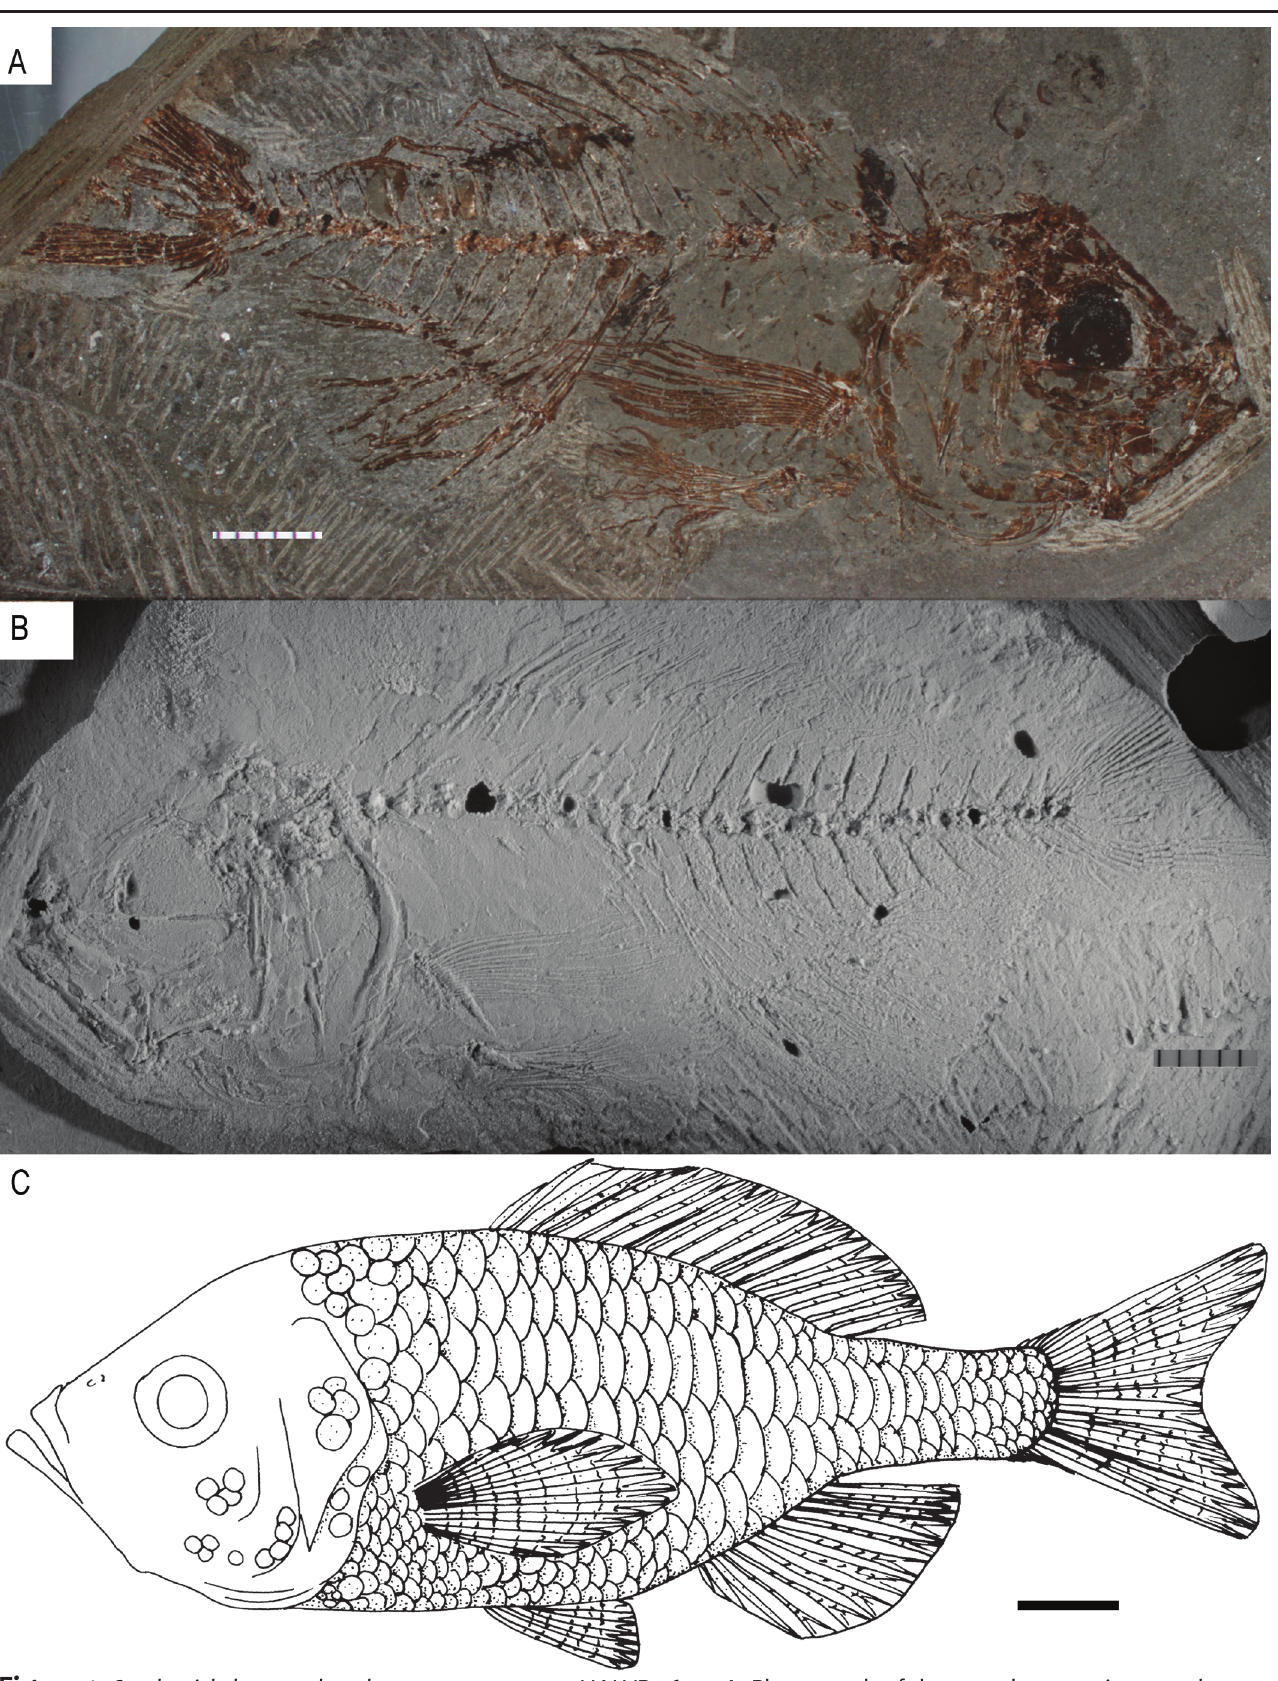
Figure 1. Cumbaaichthys oxyrhynchus gen. et sp. nov., UALVP 56113. A, Photograph of the complete specimen under polarized light; B, a silicone peel of the specimen coated with ammonium chloride; C, reconstruction of the whole fish including squamation; the true shape of the tail cannot be determined. Scale bar equals 5